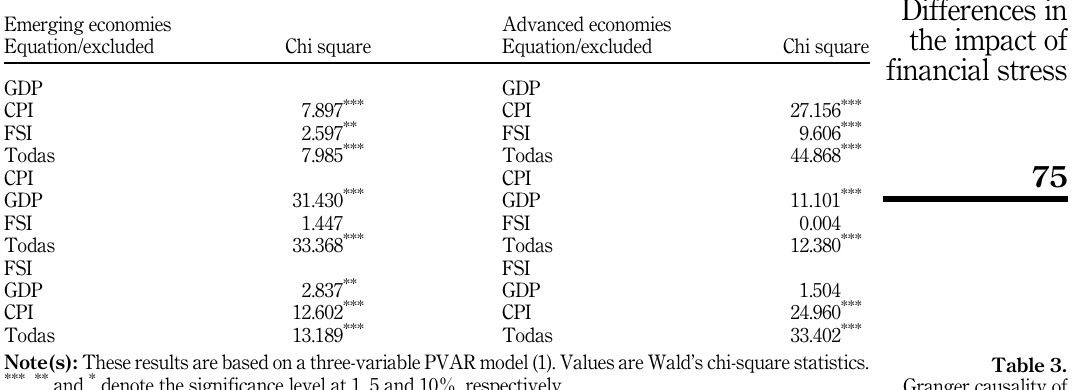
Table 3. Granger causality of the base